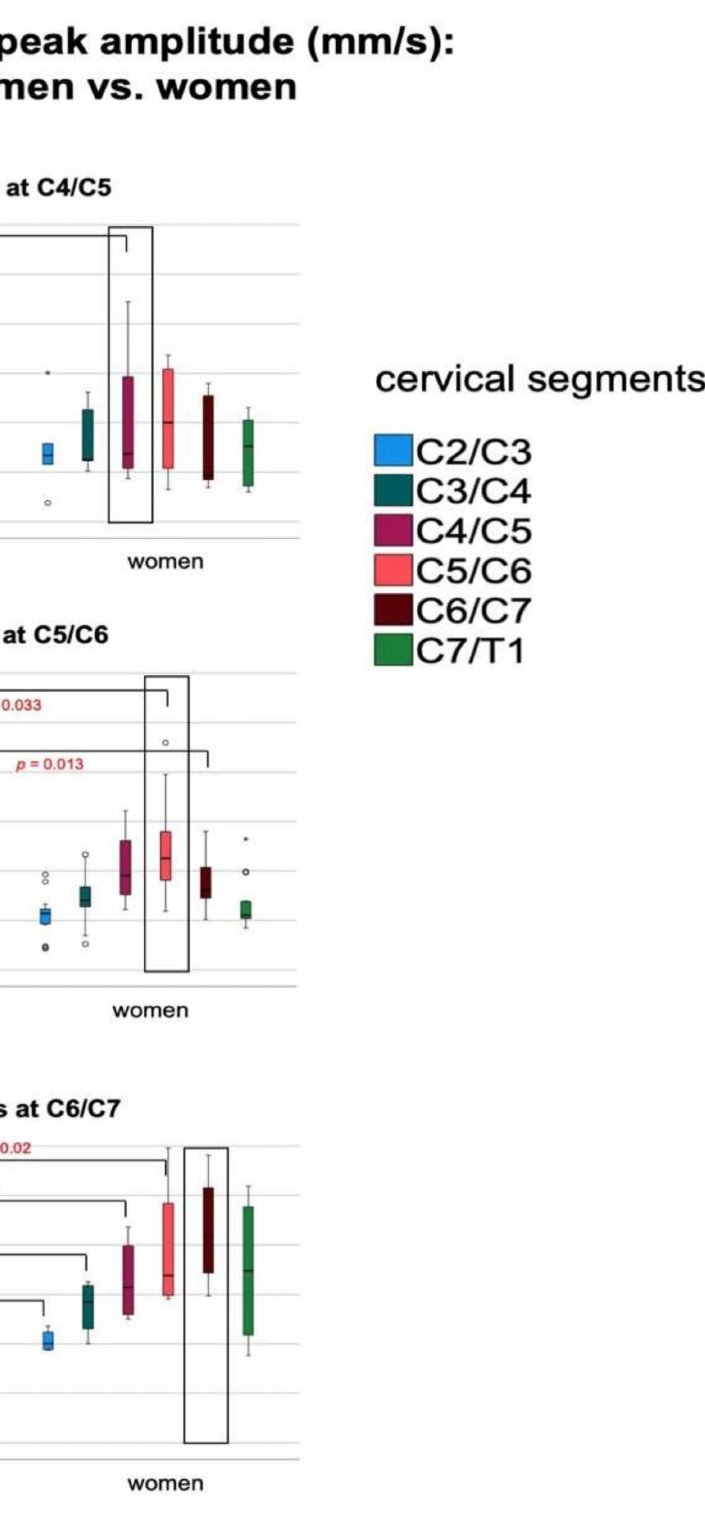
Figure 5. Boxplots demonstrating differences of peak-to-peak amplitudes (mm/s) between men and women. Level of significance is provided in brackets, borderline significance in black lettering, and significant difference in red lettering. The typical increase toward levels of stenosis followed by a decrease can be observed among all groups (black rectangle). Men with stenosis at C6/C7 show a significant decrease of spinal cord motion prior to the stenotic segment. Mild outliers are indicated by ◦ (1.5 to 3.0 × interquartile range), extreme outliers by * (>3.0 × interquartile